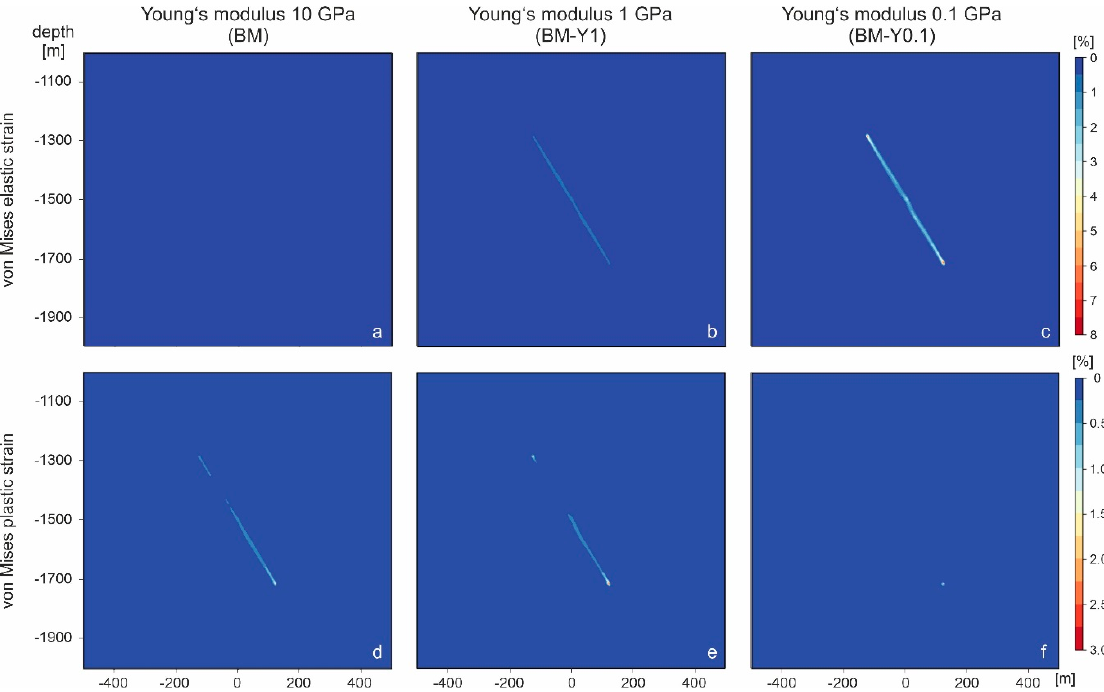
Figure 5. Spatial variations in van Mises elastic ( a – c ) and plastic ( d – f ) strain after five years of injection for three di ff erent Young’s modulus values assigned to the fault zone.